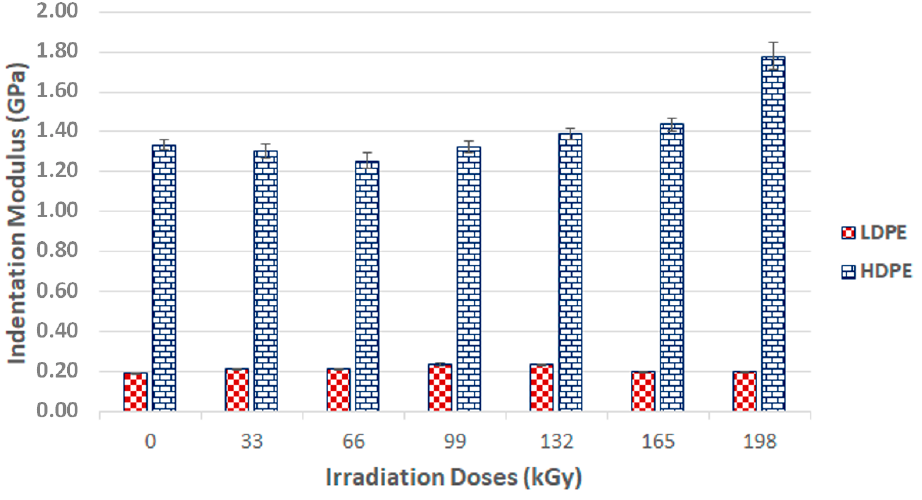
Figure 9. Indentation modulus ( E IT ) of irradiated LDPE and HDPE; the vertical line drawn at the top of the column represents the standard deviation.